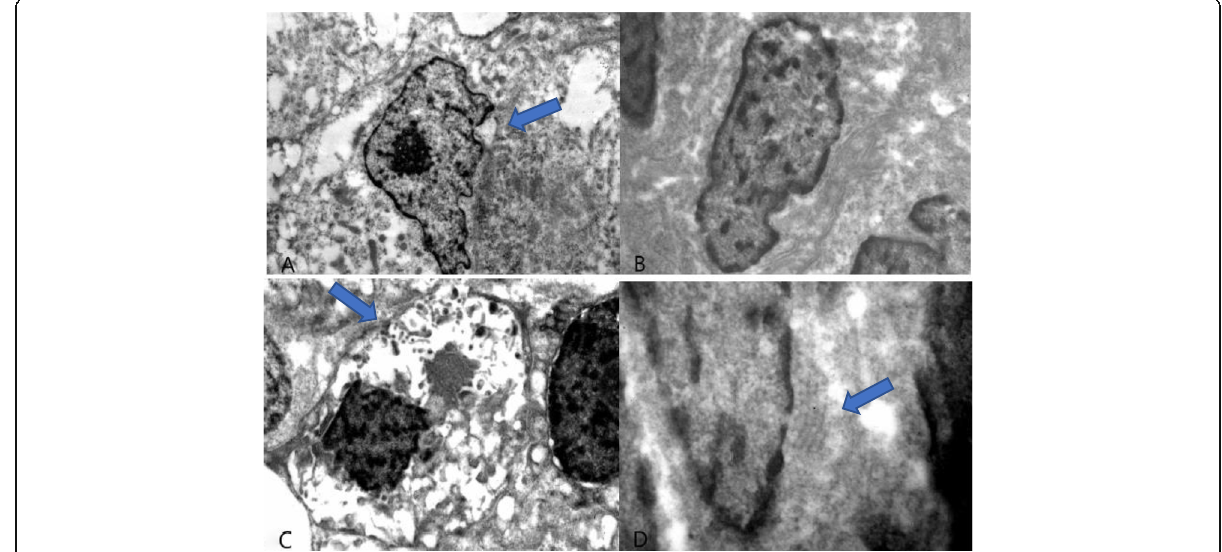
Fig. 4 Ultrastructural features of the